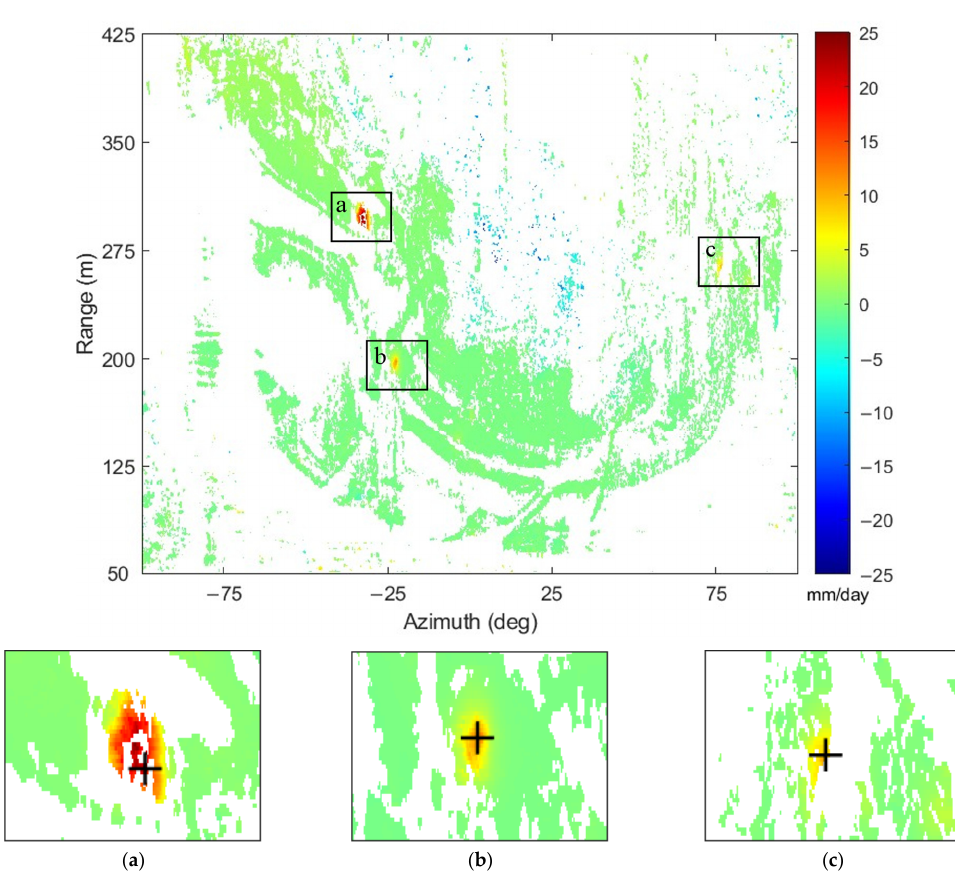
Figure 8. The average deformation rate from 3 April to 4 April 2021 obtained with the sequential estimation method and the three significant deformation regions ( a – c ).